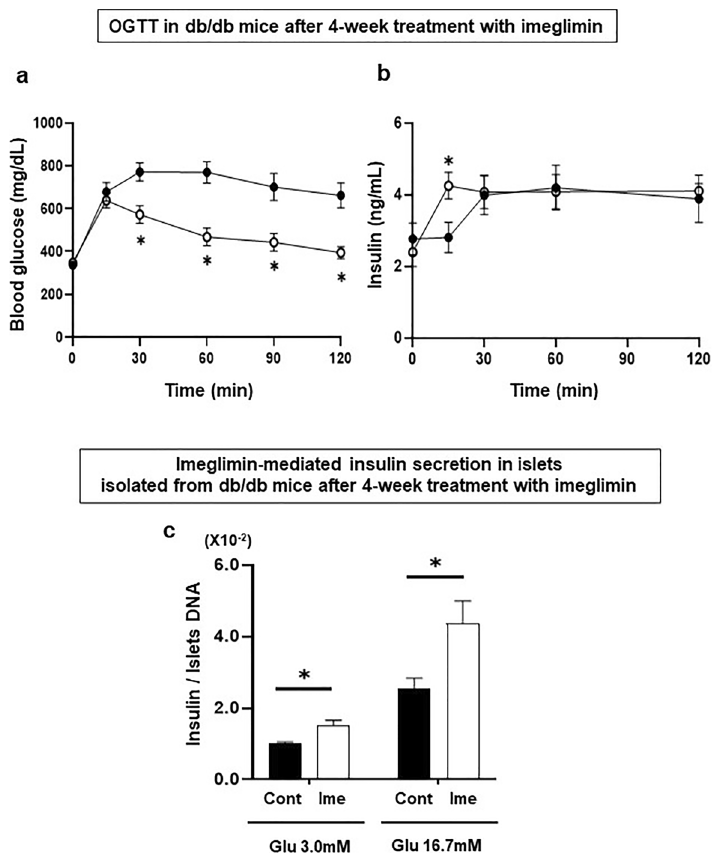
Figure 2. ( a , b ) Effects of chronic administration of imeglimin on blood glucose and serum insulin levels in obese type 2 diabetic db/db mice. In oral glucose tolerance test after 4-week administration of imeglimin in db/db mice, blood glucose levels were significantly lower in the mice treated with imeglimin together with significant increase of insulin secretion compared to those without the treatment (control: black circle, imeglimin: white circle, n = 6). ( c ) Glucose-stimulated insulin secretion in islets isolated from db/db mice after 4-week treatment with imeglimin. Insulin secretion was significantly increased in the mice treated with imeglimin compared to those without the treatment (n = 8). Values are the mean ± SEM of data obtained from each group. * p <